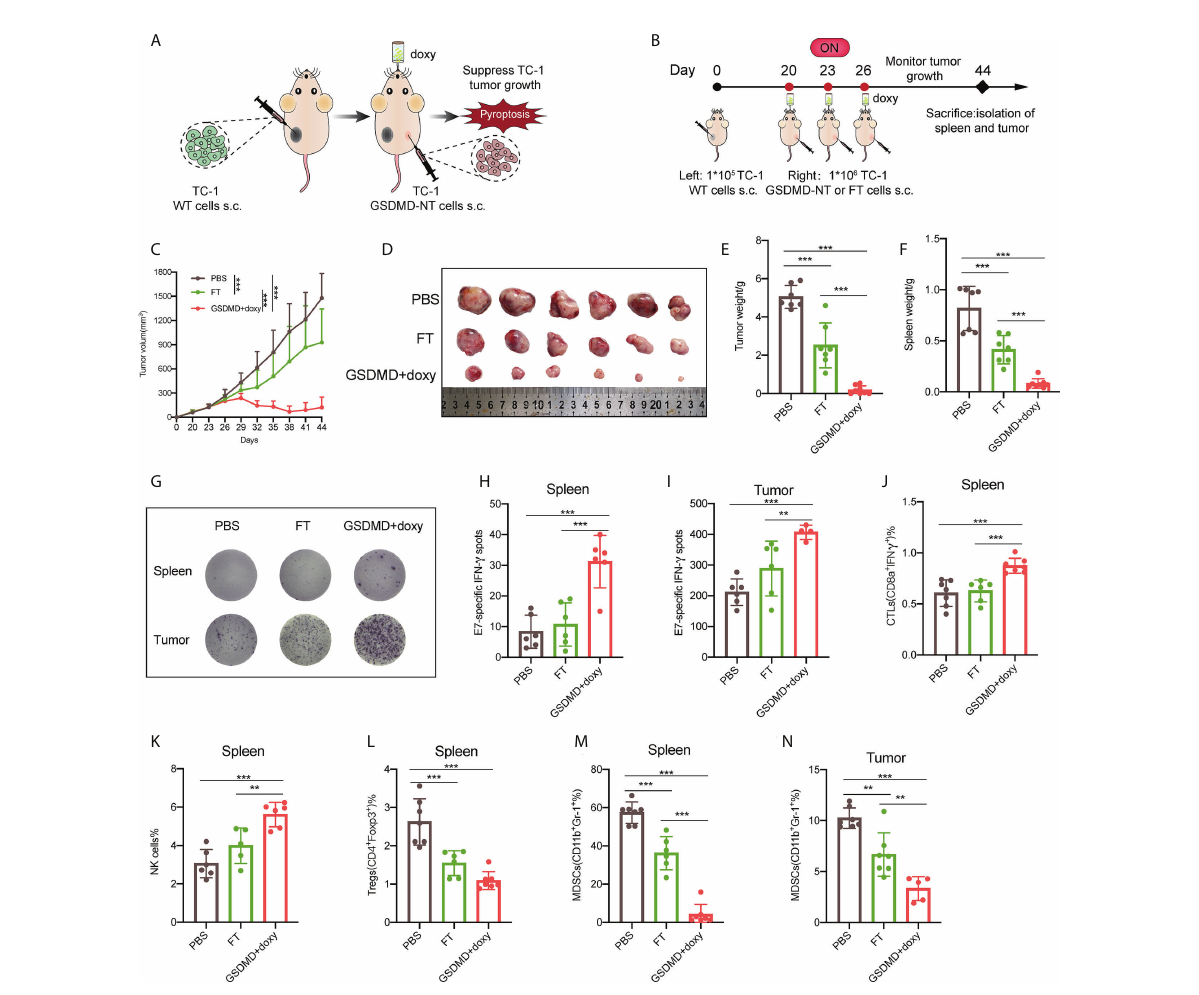
FIGURE 7 Therapeutic immunization with the novel pyroptotic tumor cell vaccine suppresses the growth of established TC-1 tumors and signi fi cantly improves the anti-tumor cellular immune responses. (A) Schematic representation of the treatment of TC-1 xenograft tumors by therapeutic immunization with the pyroptosis-inducible tumor cells. (B) The experimental protocol (n=8). (C) Tumor growth curves by groups. (D) The size of the tumor mass (n=6). (E) The weight of the tumor mass. (F) The weight of the spleen. (G) Representative images of E7-speci fi c IFN- g - expressing lymphocytes isolated from the spleen and tumor tissues (n=6). (H, I) Statistical analysis of the ELISPOT results of E7-speci fi c IFN- g - expressing lymphocytes in the spleens and tumors. (J – M) Flow cytometry analyses of lymphocytes isolated from the spleen, including CTLs (IFN g + CD8 a + ) (J) , natural killer cells (NK1.1 + ) (K) , Tregs (CD4 + Foxp3 + ) (L) , and MDSCs (CD11b + Gr-1 + ) (M) . (N) MDSCs (CD11b + Gr-1 + ) detected by fl ow cytometry in tumors. (C, E, F, H – N) Graph shows means ± SD, One-way ANOVA, ** p value < 0.01, *** p value <